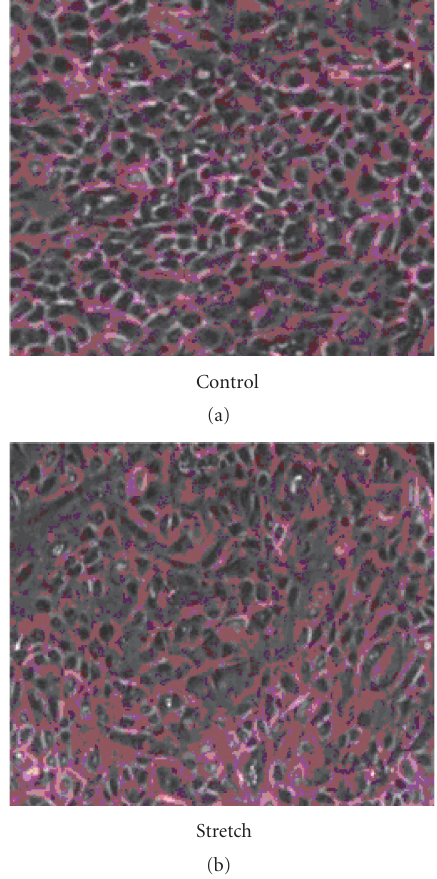
Figure 5: There were no remarkable morphological changes that could be seen between the control group and the stretching group at 0